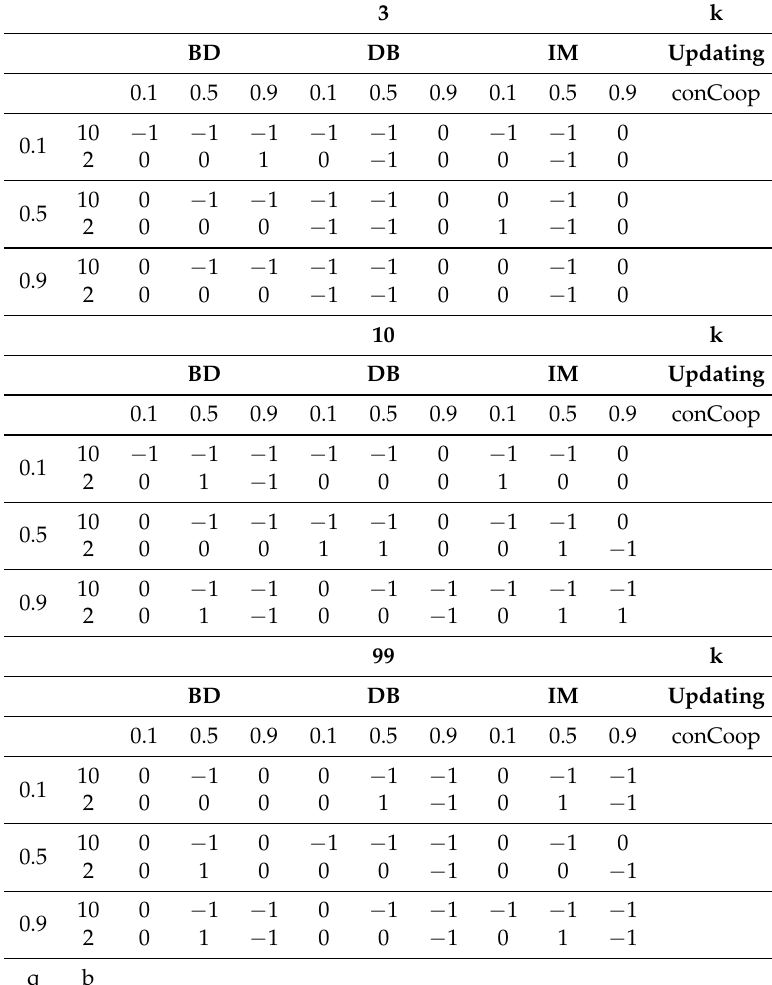
Table B1. Difference in the ratio of defectors during the last iteration of the